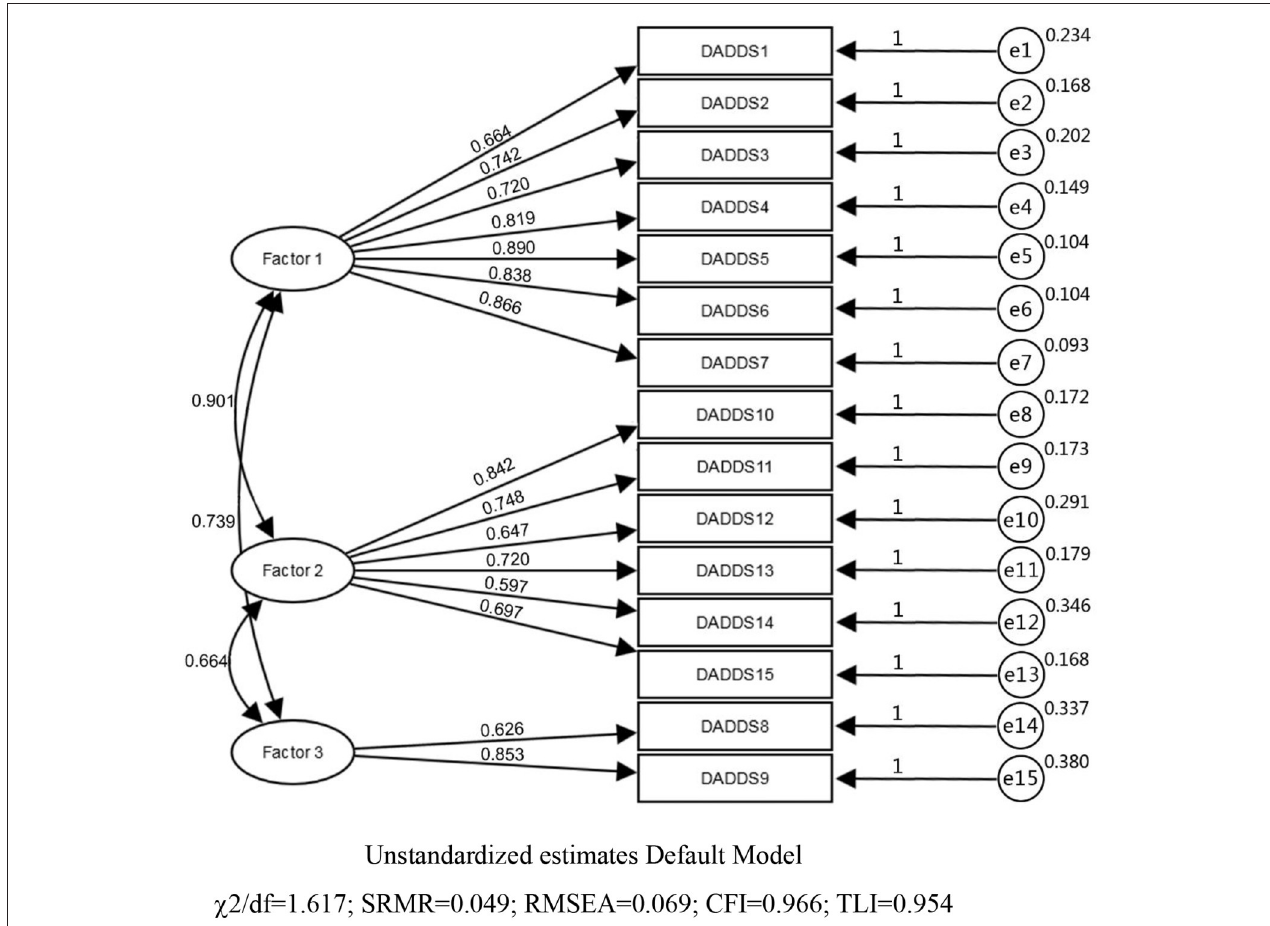
FIGURE 2 | Three factors model in confirmatory factor analysis.